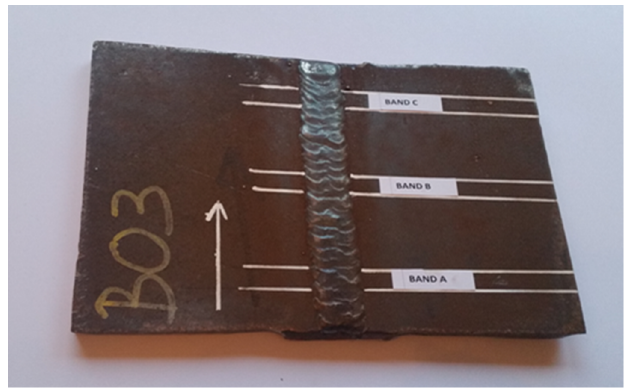
Figure 1. Welding sample with marked measurement areas.